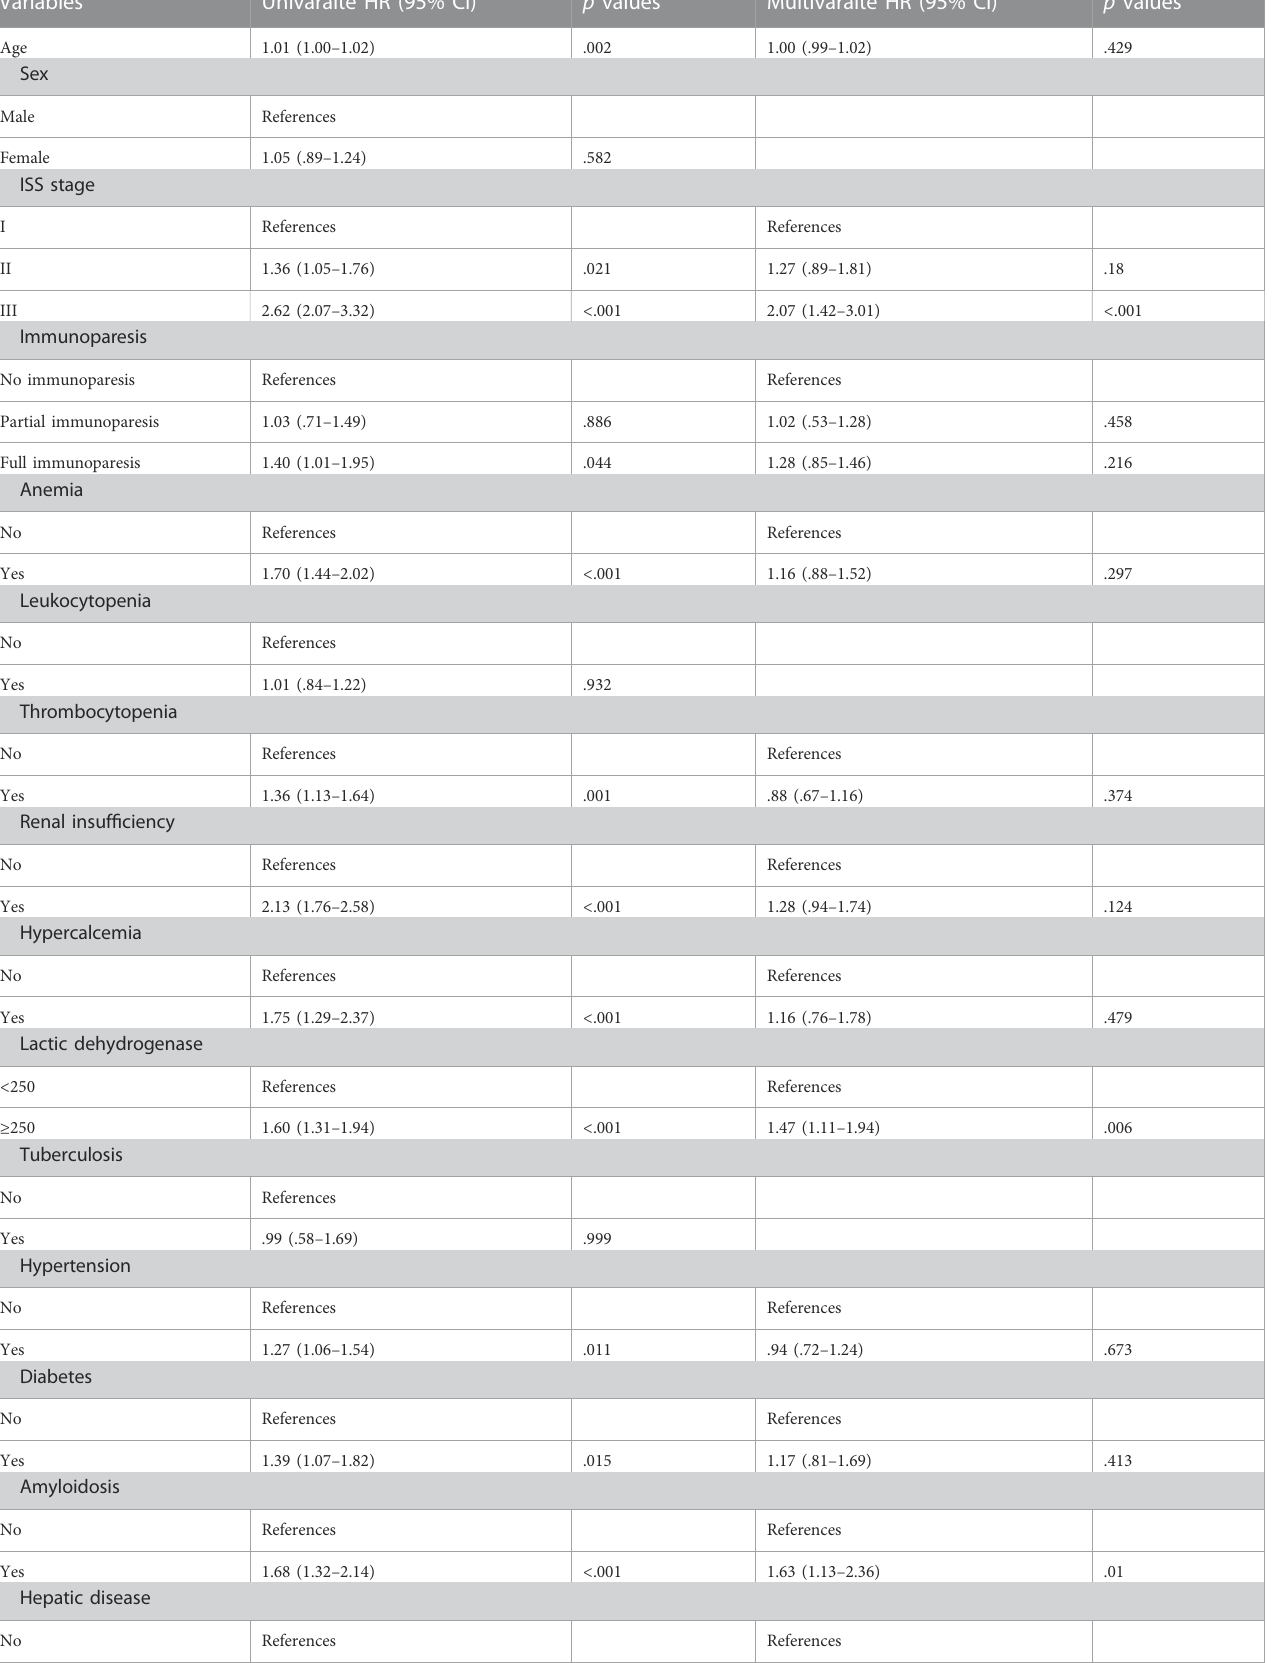
TABLE 3 Univaraite and multivaraite Cox regression models regarding factors associated with attrition